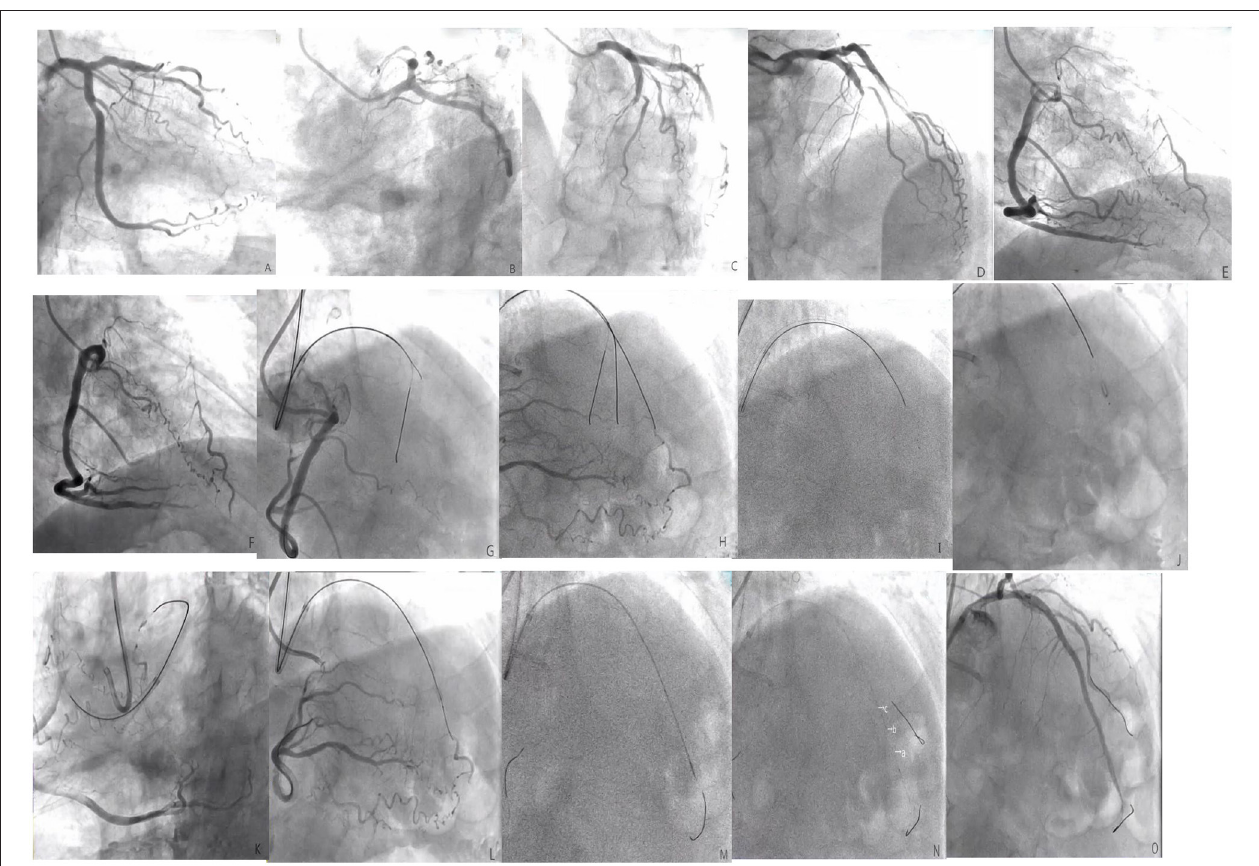
transluminal coronary angioplasty guidewire is SION. Corsair microcatheter is sent to the proximal end of LAD occlusion segment under the guidance of SION, XT-R finger guidewire is replaced, which does not pass through LAD occlusion lesion (shown by black arrow); (H) , upgrade the guidewire several times and finally allow